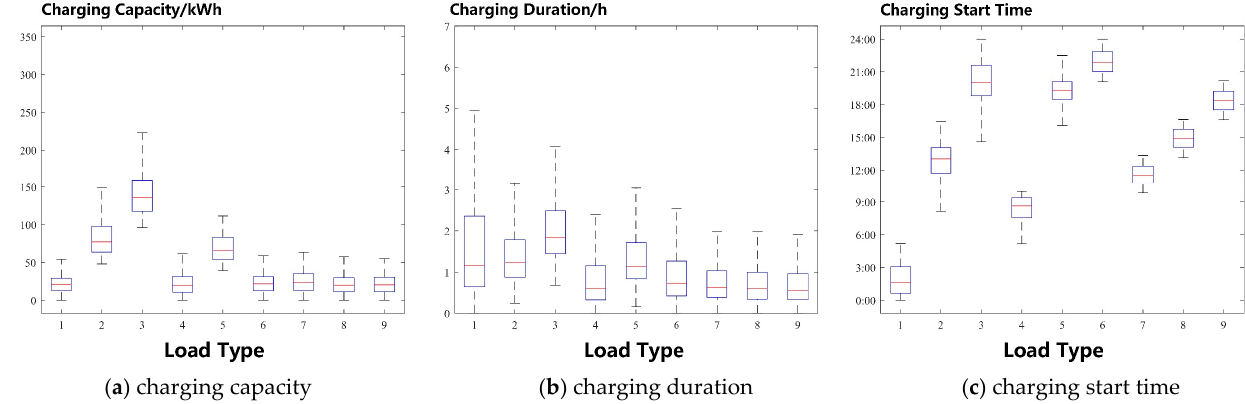
Figure 7. The box figure of each type of load. 4.2.2. Adjustment Flexibility and Valley Filling Potential The calculation results of R F and F V